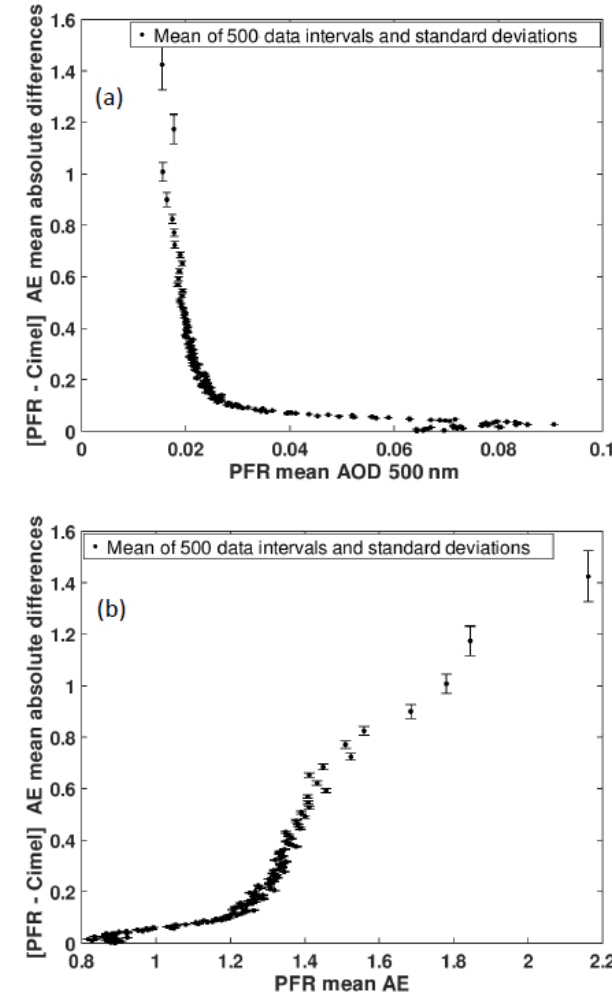
Figure 10. (a) Cimel–PFR AE mean absolute differences (and cor- responding standard deviations) versus PFR mean AOD 500nm in 500 data intervals (b) and versus PFR mean AE in 500 data inter- vals. AE has been computed for both PFR and Cimel using the four common channels (380, 440, 500 and